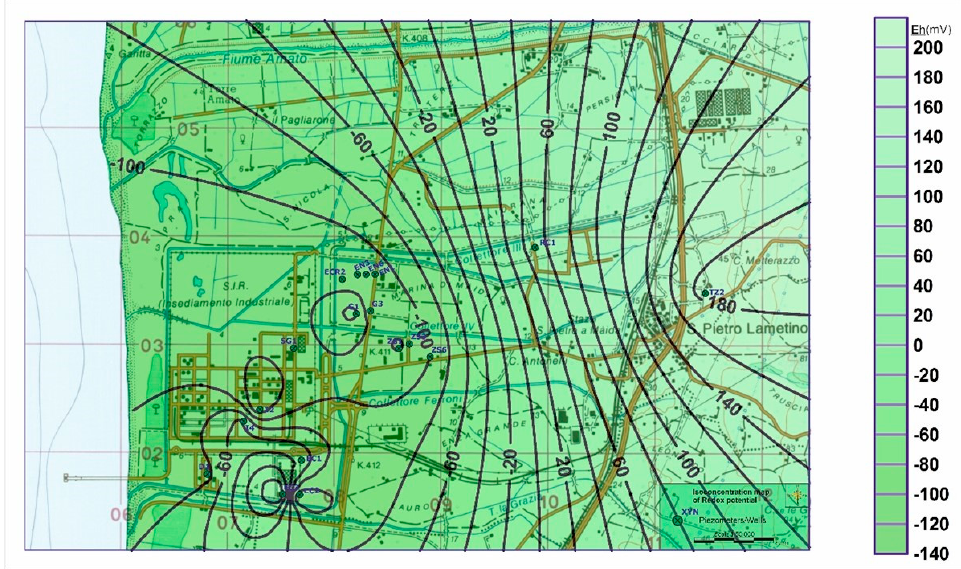
Figure 7. Isodistribution Map of Redox Potential (Median Values) (Modified) [6]. The map highlights, an innermost sector of the study area with positive redox values and a sector along the coast with negative redox potential values. These correspond to the more oxygenated and less oxygenated sectors of the aquifer, respectively.